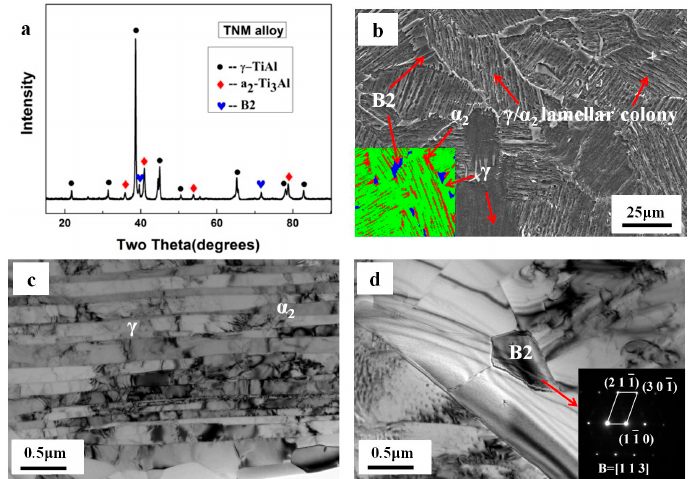
Figure 2. ( a ) XRD spectra showing that γ‐ TiAl, B2 and α 2 ‐ Ti 3 Al phases exists in TNM alloy; ( b ) SEM image and EBSD image showing the γ phase (green color), α 2 phase (red color) and B2 phase (blue color); ( c , d ) TEM images and corresponding selected area electron diffraction (SAED) pattern showing the γ / α 2 lamellae and B2 phase.